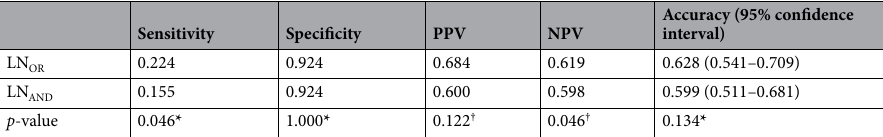
Table 4. Diagnostic performance of regional LN metastasis by LN OR and LN AND definitions. PPV, positive predictive value; NPV, negative predictive value; LN OR , regional LN metastasis on preoperative CT or FDG- PET ( 18 F-fluoro-2-deoxyglucose-positron emission tomography) scans; LN AND , regional LN metastasis on preoperative CT and FDG-PET scans; *McNemar’s test was used. † Generalised estimating equation was